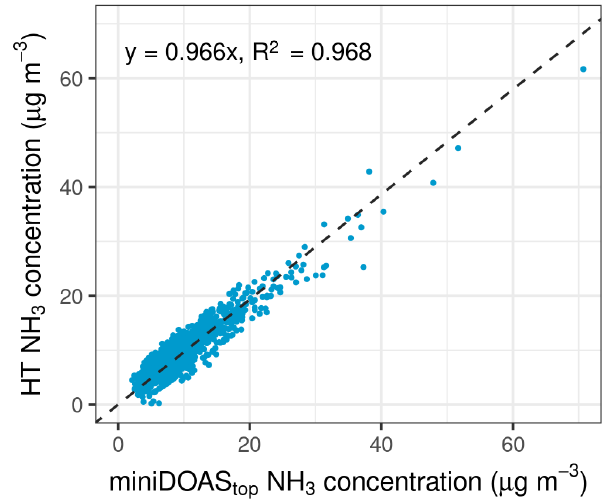
Figure 5. Scatter plot of the NH 3 concentrations from the miniDOAS top and the temperature-corrected HT instrument during parallel measurements (correlation line was forced through the ori-